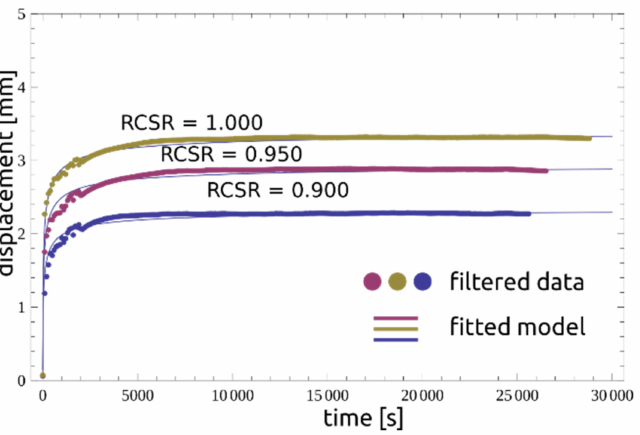
Figure 8. Comparison between the fitted Blair model and filtered data for RCSR = {0.9000, 0.9500, 1.0000}.